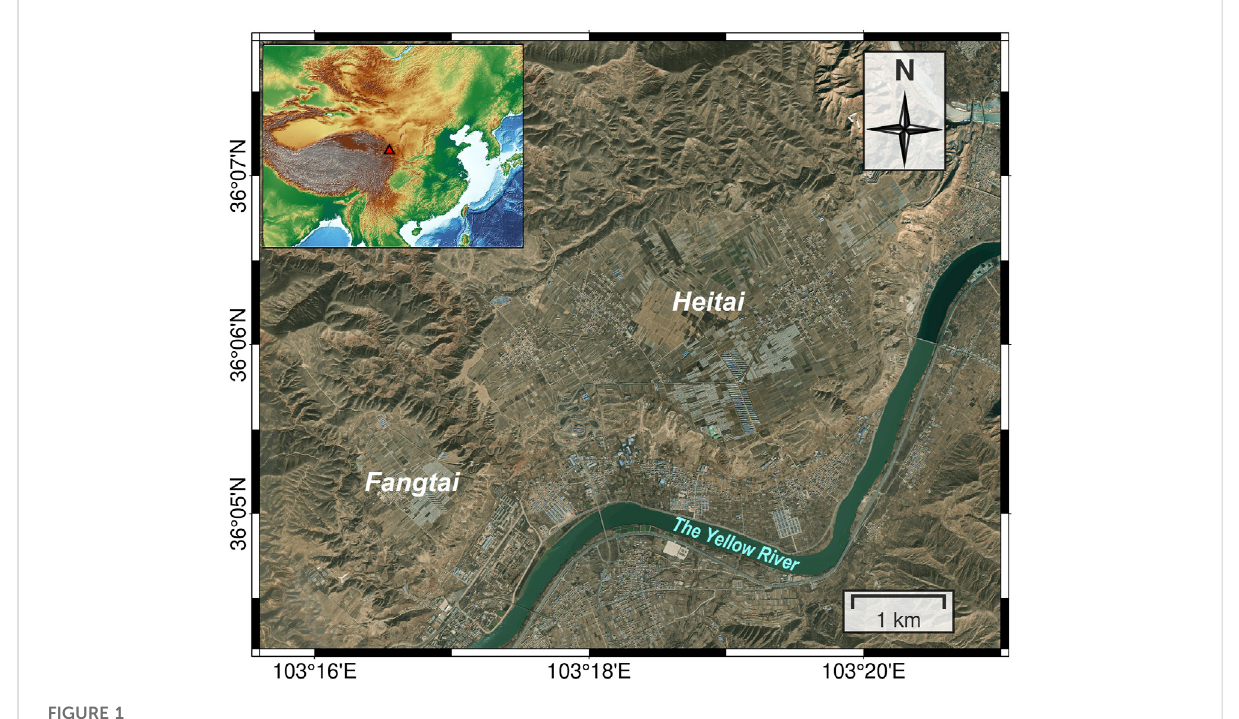
Landscape of Heifangtai and its location indicated as a red triangle in the